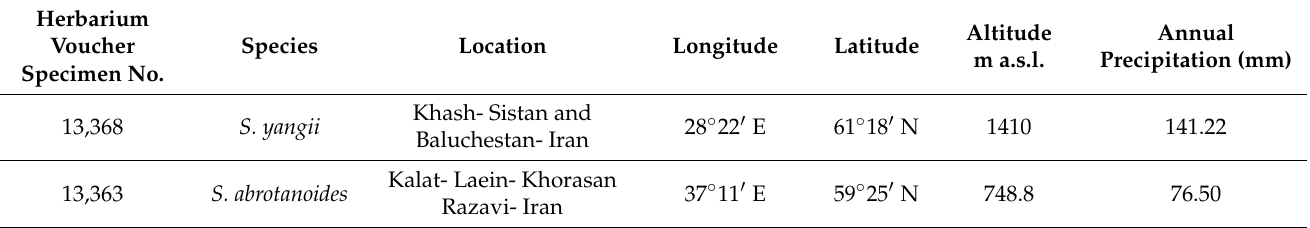
Table 1. The origin and taxonomic identification of studied Salvia